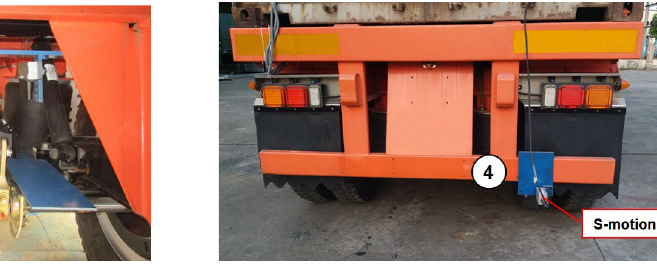
Figure 7. Sensor locations . Figure 7. Sensor